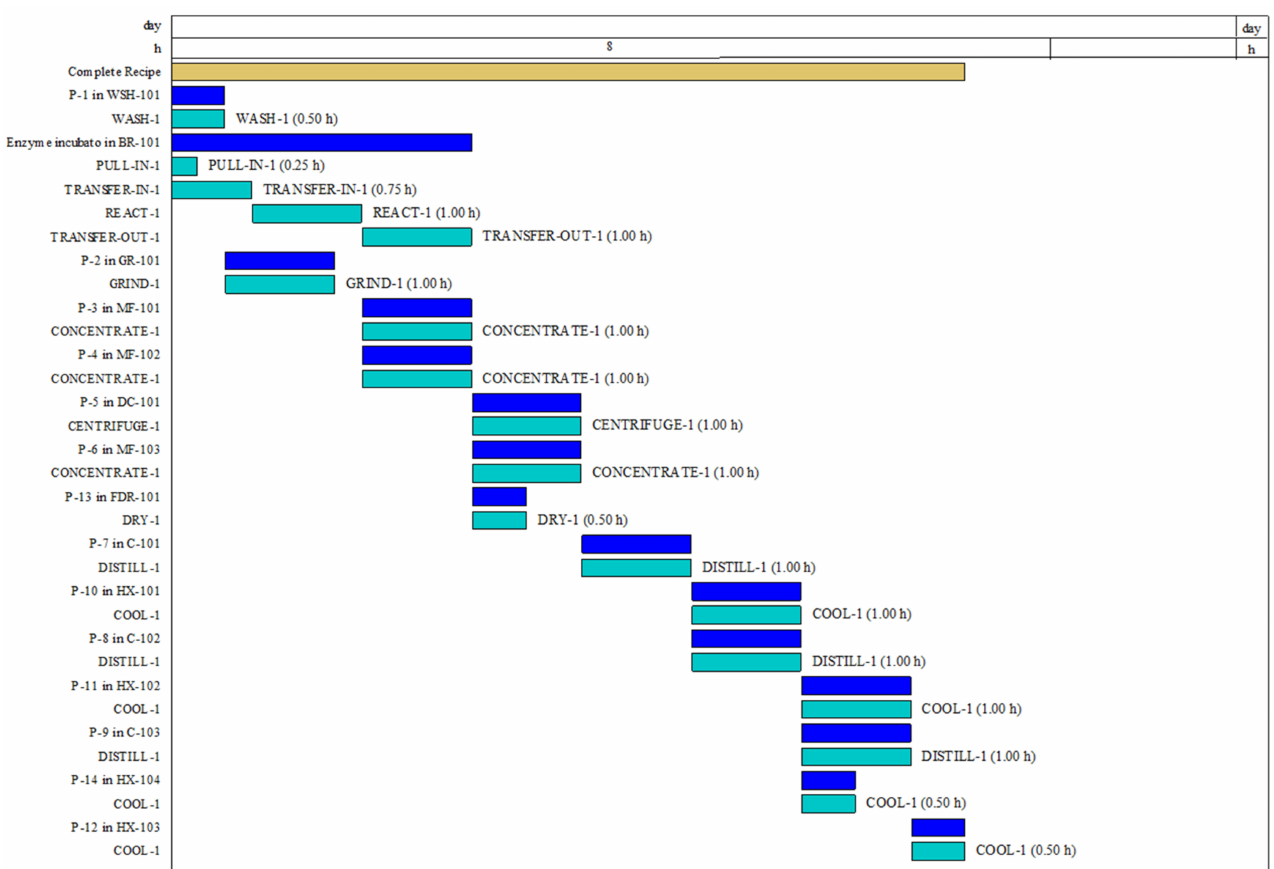
Figure 2. The production plant Gantt chart for scheduling purposes.